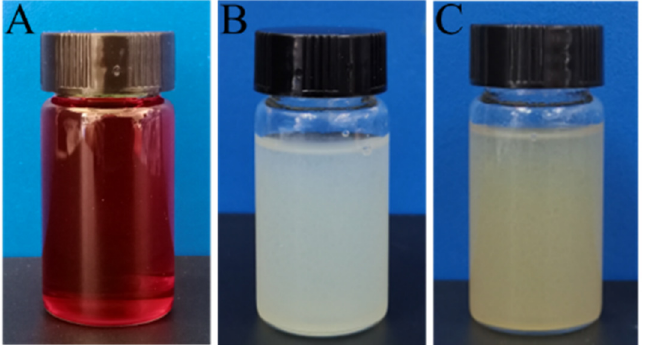
Figure 2. ( A , B ) Photographs of ANFs in DMSO (0.2 wt%) and water (0.1 wt%); ( C ) photograph of an aqueous TA@ANFs dispersion (0.1 wt%). All of the dispersions shown in these photographs had been stored for 24 h.